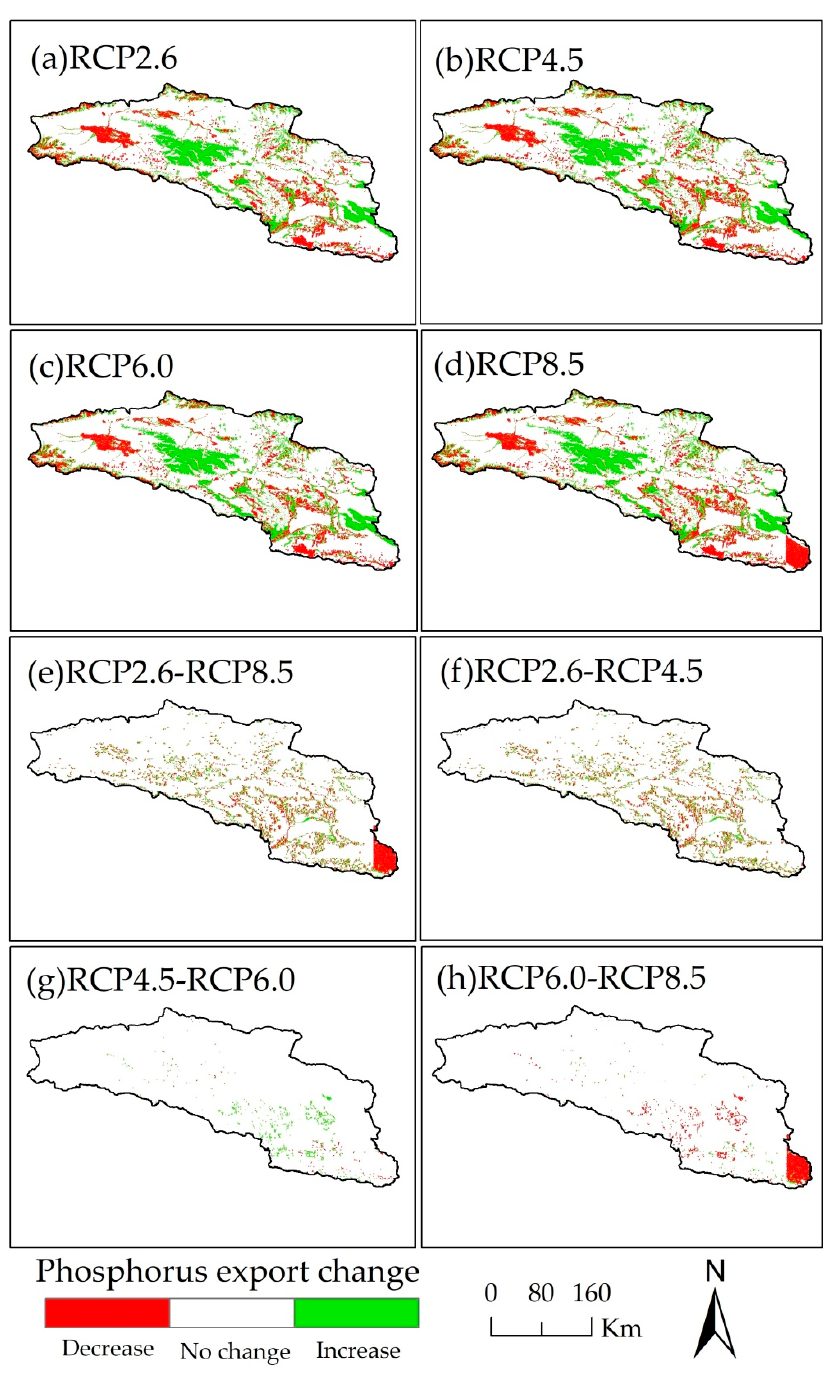
Figure 8. The spatial distribution of phosphorus export change of Bosten Lake basin in 2050 for RCP scenarios and in 2015 ( a – d ), between different RCP scenarios in 2050 ( e – h ).